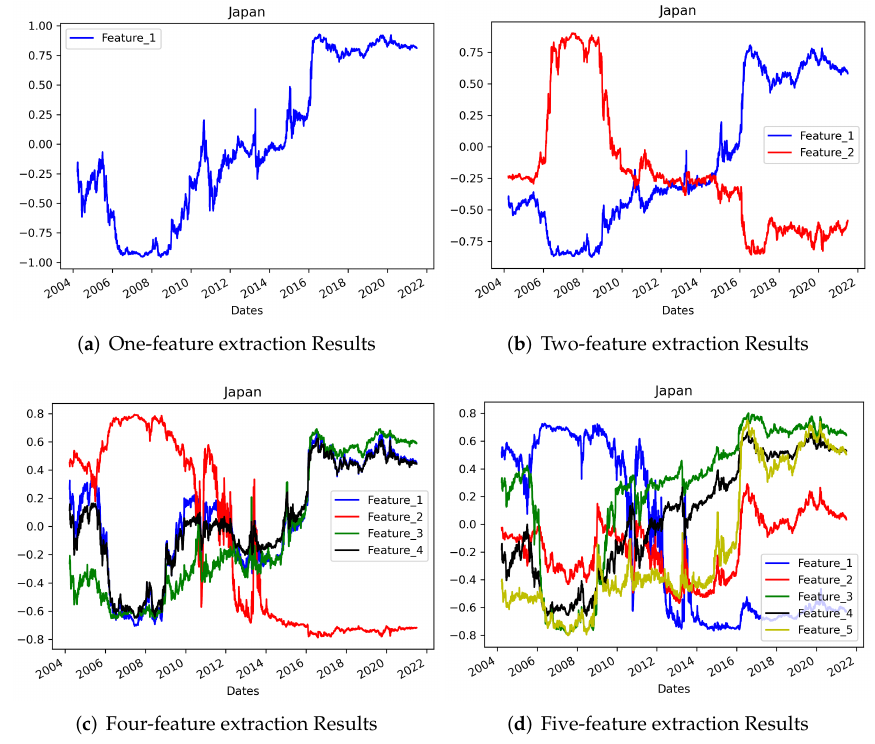
Figure 20. AE Results for the Japan data with different density